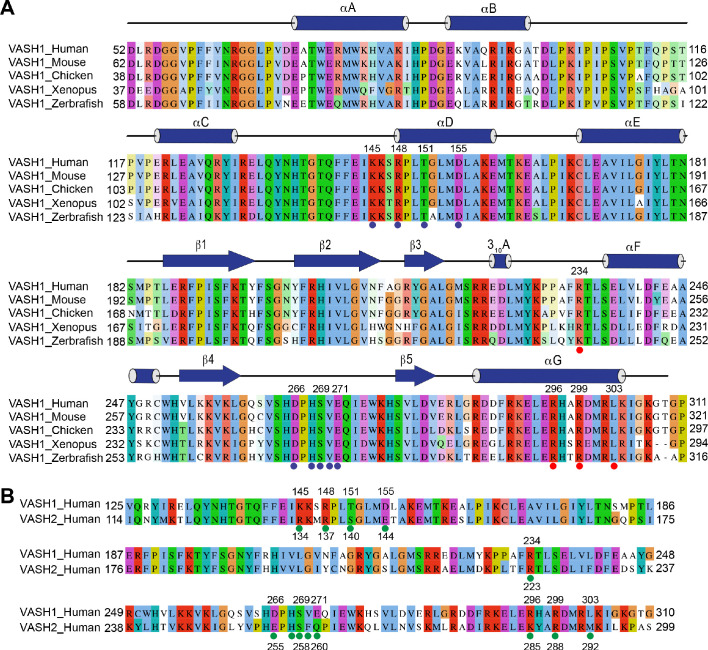
Sequence alignment of VASH1 and VASH2 proteins.